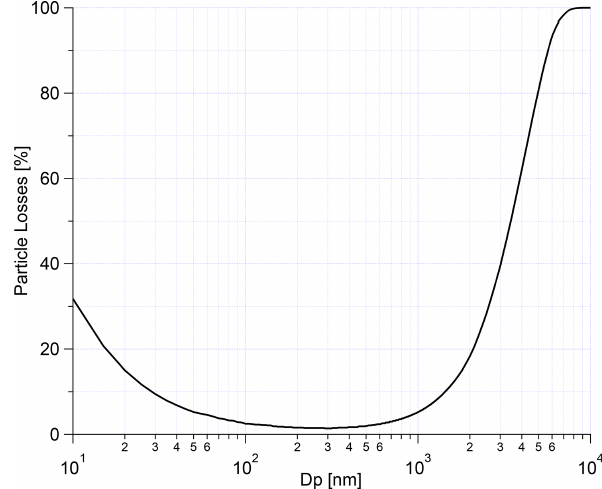
Figure A1. Size-dependent particle loss through the inlet at the CVAO